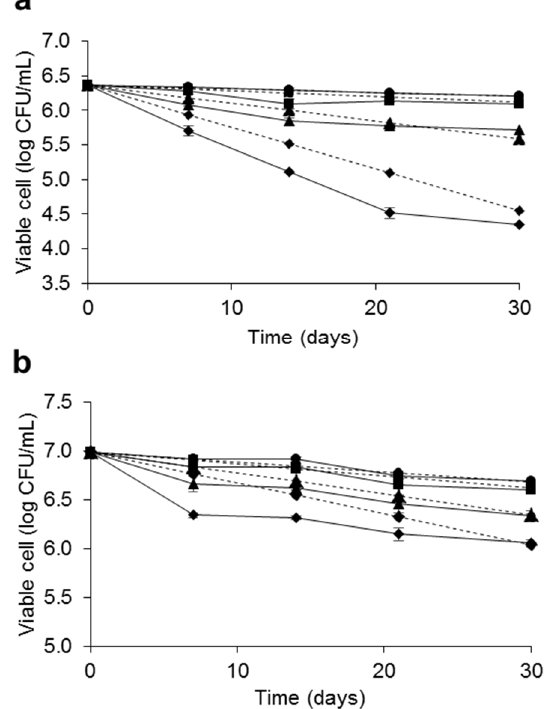
Figure 9. Accelerated stability of the freeze-dried spores of L. fusiformis 5.1 ( a ) and L. xylanilyticus 4.3 ( b ) at 8 ( • ), 15 ( (cid:4) ), 37 ( (cid:78) ) and 55 ◦ C ( (cid:7) ); ——, experimental and—-, predicted viability. Values are mean ± SD. The SD value was shown in supplementary Table S3.